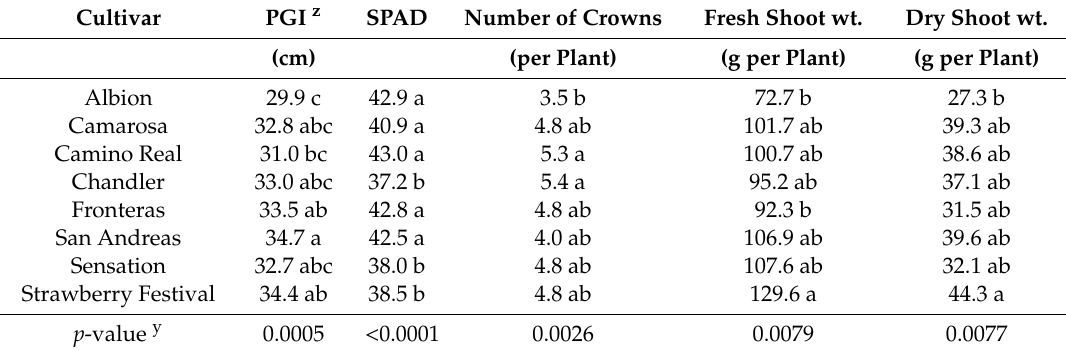
Table 2. Vegetative growth of six June-bearing (“Camarosa”, “Camino Real”, “Chandler”, “Fronteras”, “Sensation”, and “Strawberry Festival”) and two day-neutral (“Albion” and “San Andreas”) strawberry cultivars grown in a high tunnel in Starkville, Mississippi from November 2017 to June 2018. Cultivar